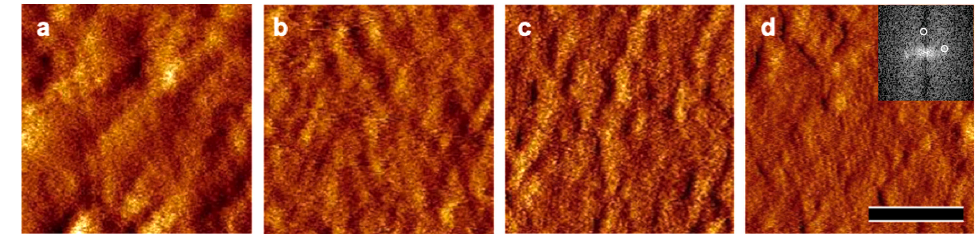
Figure 4. Atomic force microscopy (AFM) pictures of rSbpA recrystallized on a silicon wafer exploiting the two-stage process. The recombinant S-Layer protein rSbpA was incubated for 10 min (50 μ g/mL crystallization buffer) and, after a washing step, incubation was prolonged. The change from the adsorbed state into the crystalline state was monitored by taking images after 10 min ( a ); 60 min ( b ); 120 min ( c ); and 140 min ( d ), respectively. The square (p4) lattice structure could be visualized after 120 min incubation in crystallization buffer (bar, 200 nm). Inset shows the first